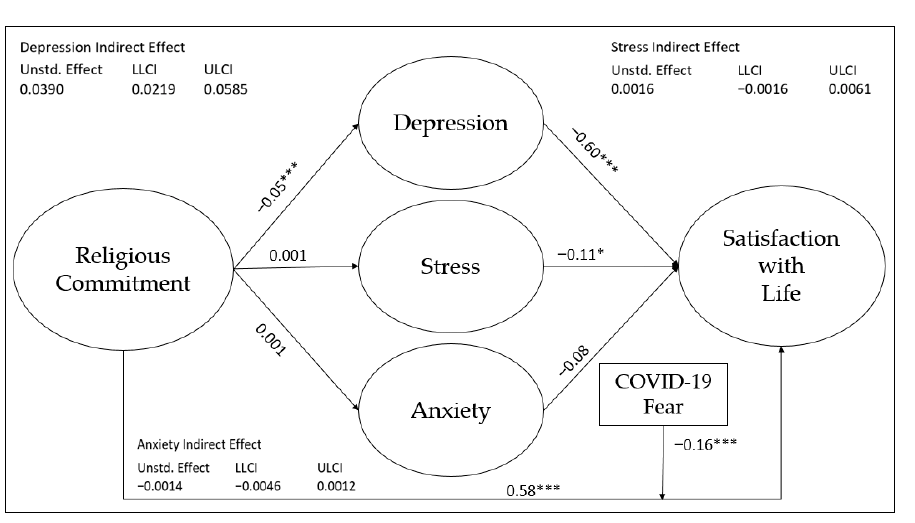
Figure 3. The proposed research model’s findings; * p < 0.05, *** p < 0.001.